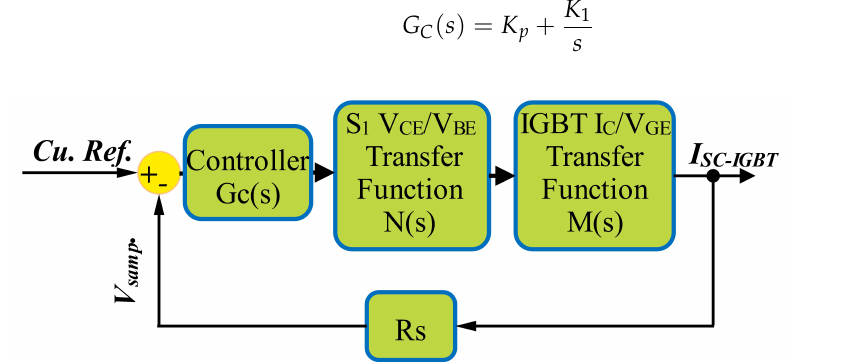
Figure 6. Schematic overview of the proposed method.